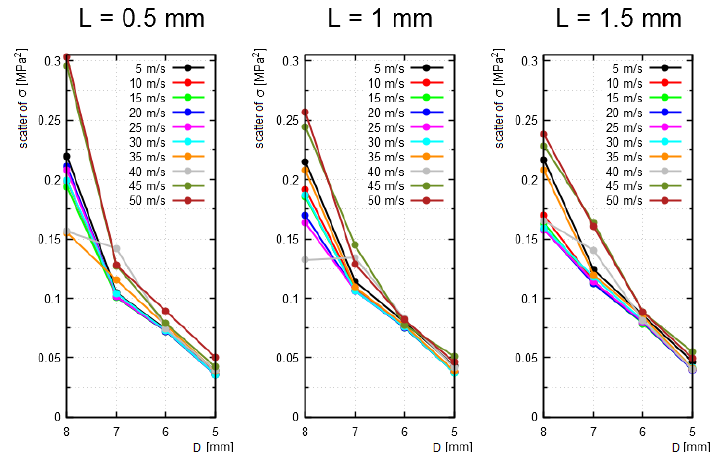
Figure 14. Influence of impacting velocity on oscillations of the pulse (L - length of the pulse shaper, D - diameter of the pulse